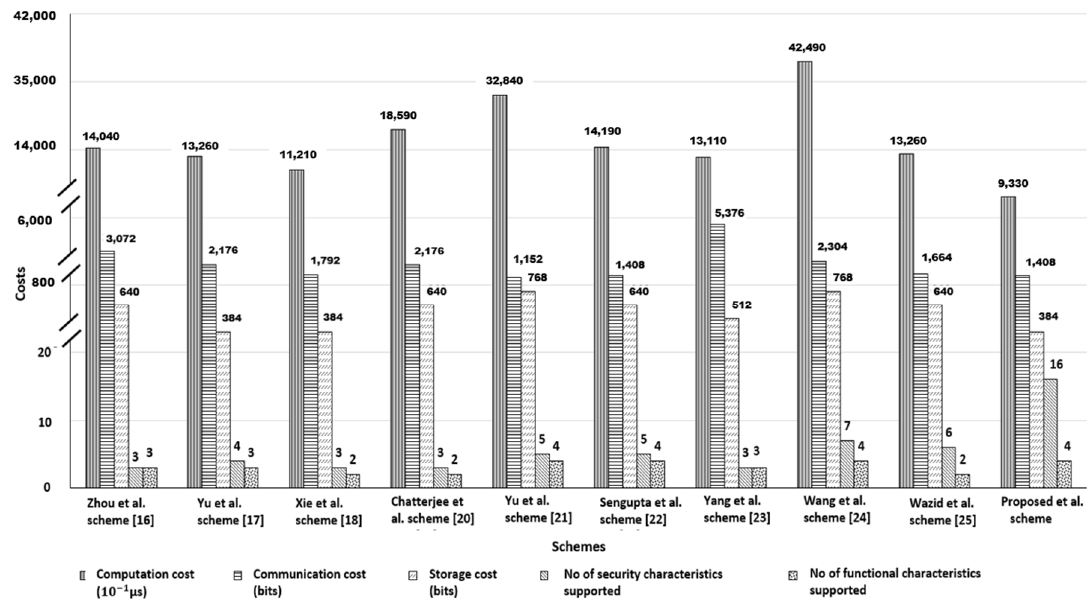
Figure 11. Summary of performance